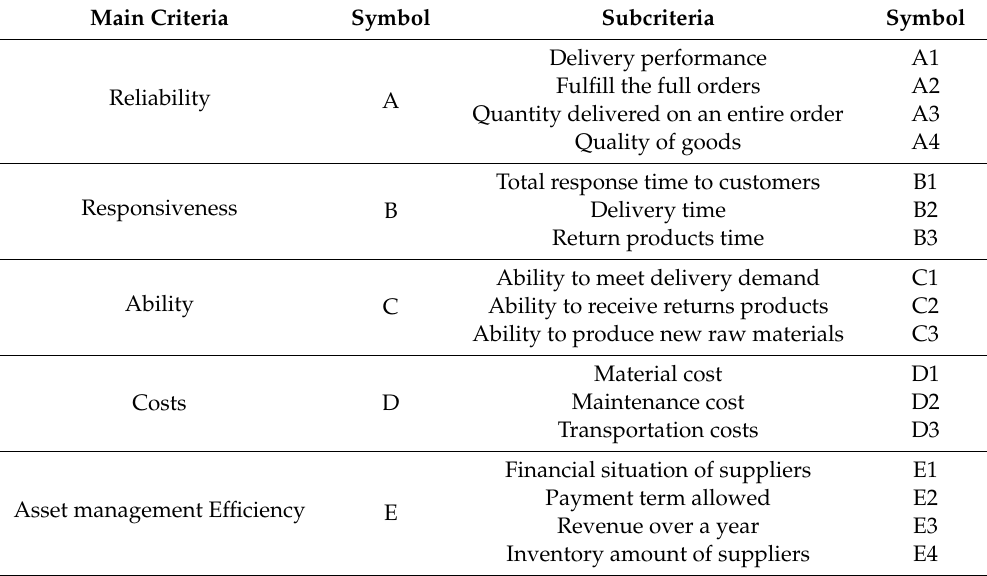
Table 5. Symbol of main criteria, sub-criteria in supplier selection.